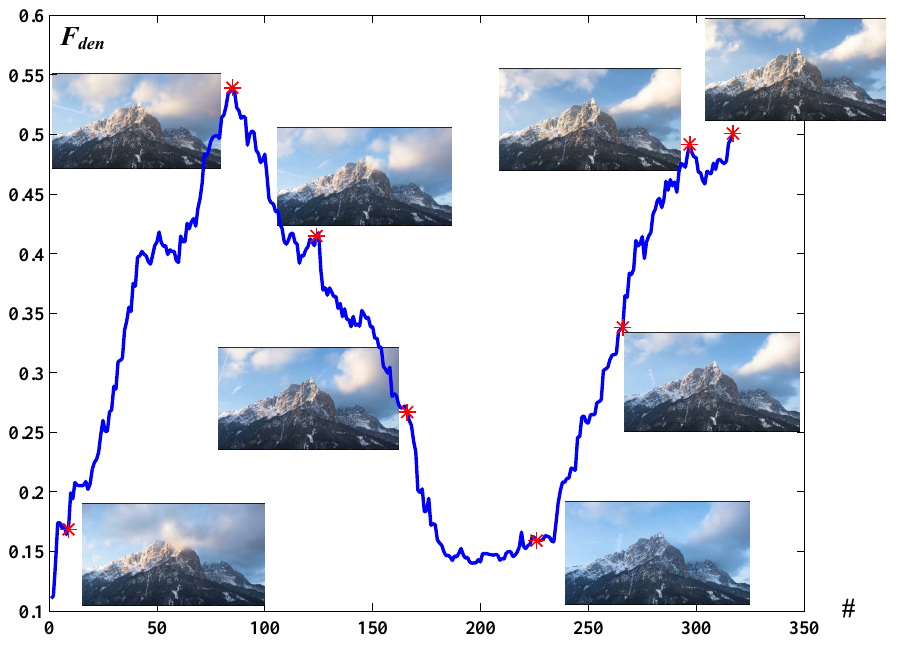
Figure 8. The changes in fog density value F den during the video.